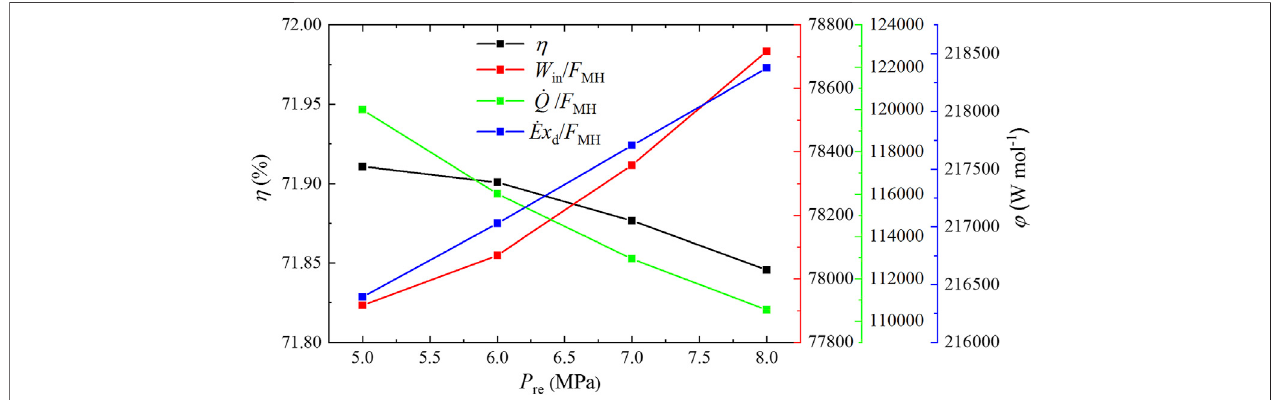
FIGURE 4 | Input power, cold energy, and exergy destruction per molar synthetic methanol and exergy ef fi ciency under different reaction pressures.